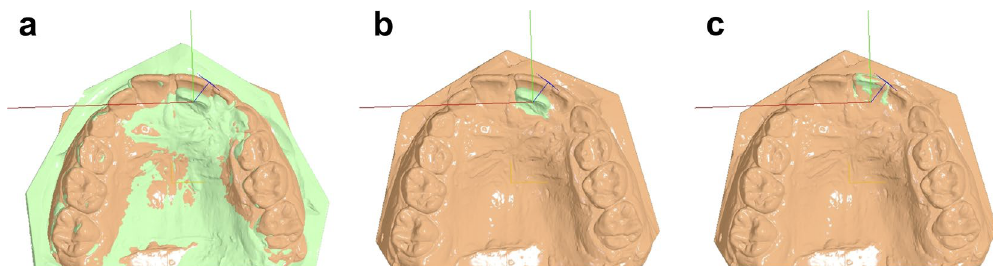
Figure 2. Example of superimposition and tooth movement assessment. ( a ) Superimposed pre-treatment (green) and follow-up (peach) models on area A. ( b ) The tooth of interest (left central incisor) was selected on the pre-treatment model (green). The axes used for the assessment of positional changes of the tooth of interest originated from the centroid of this tooth in the pre-treatment position and were oriented according to the occlusal plane and the midline palatal suture. ( c ) Finally, the pre-treatment tooth of interest was superimposed to the post-treatment tooth and thus the exact positional change was